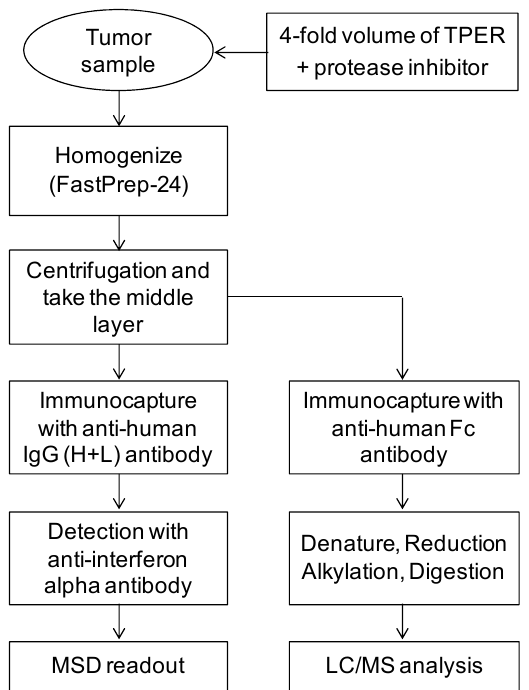
Figure 2. Workflow of tumor sample preparation and immunocapture for LBA and IC-LC / MS. Table 1. Assay precision and accuracy for LBA and human IgG4 / interferon alpha signature peptide by IC-LC / MS in mouse plasma and